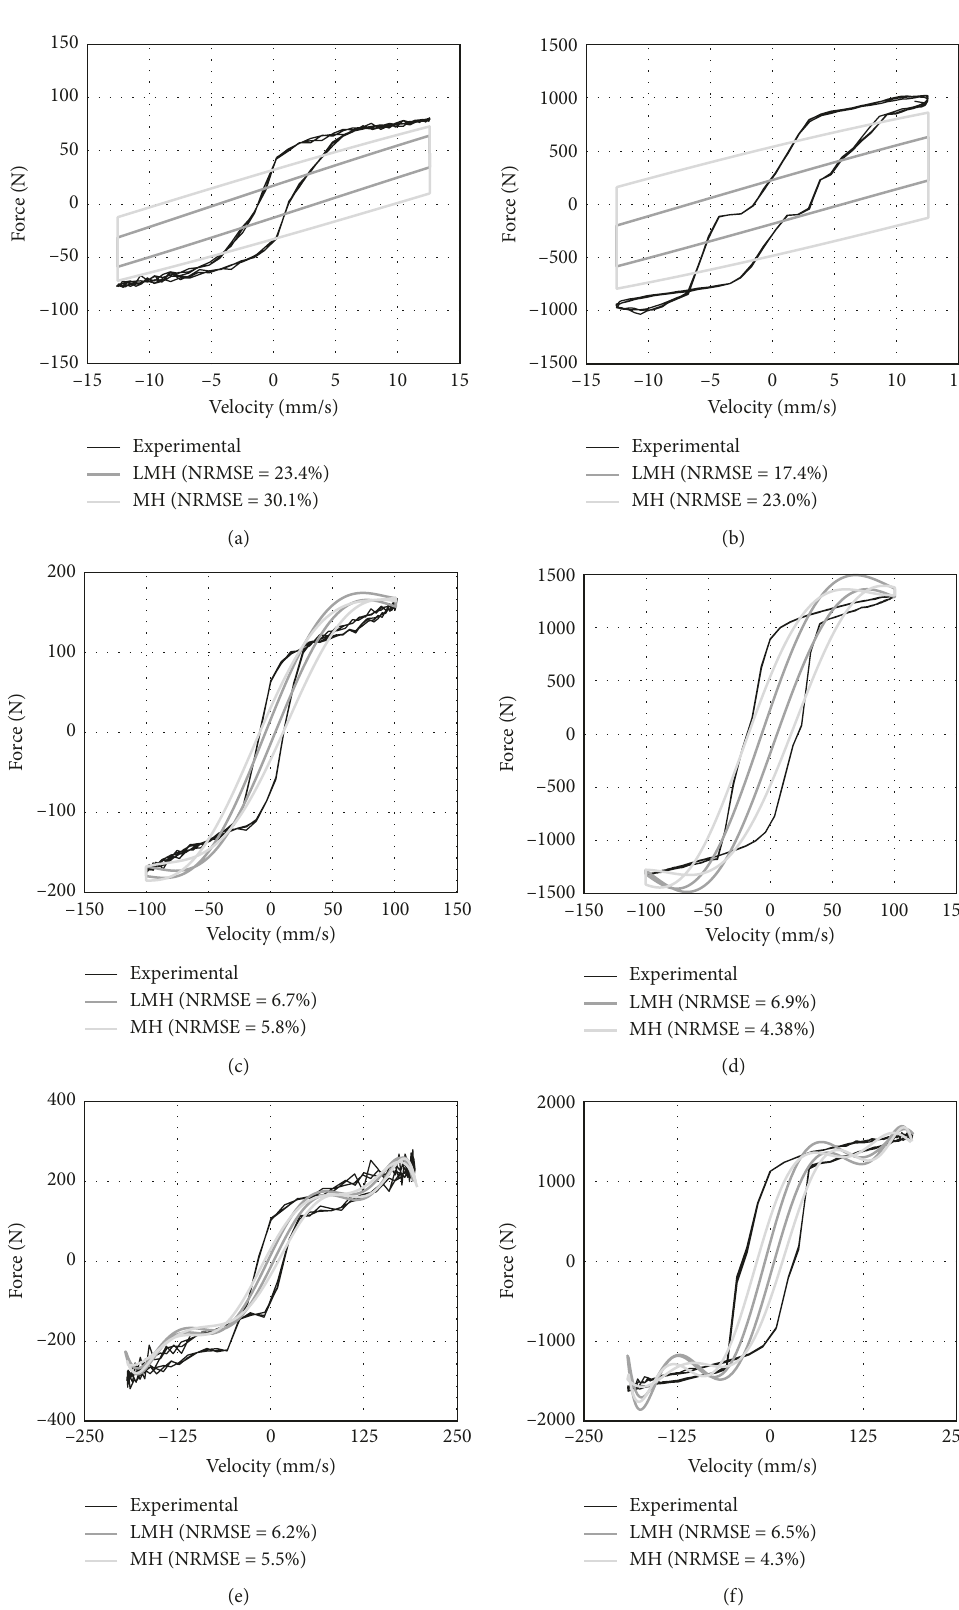
Figure 14: Polynomial model (fitted with LMH and MH tests) predictions for six different tests: (a) low velocity without intensity; (b) low velocity with I � 1 A; (c) medium velocity without intensity; (d) medium velocity with I � 1A; (e) high velocity without intensity; (f) high velocity with I �